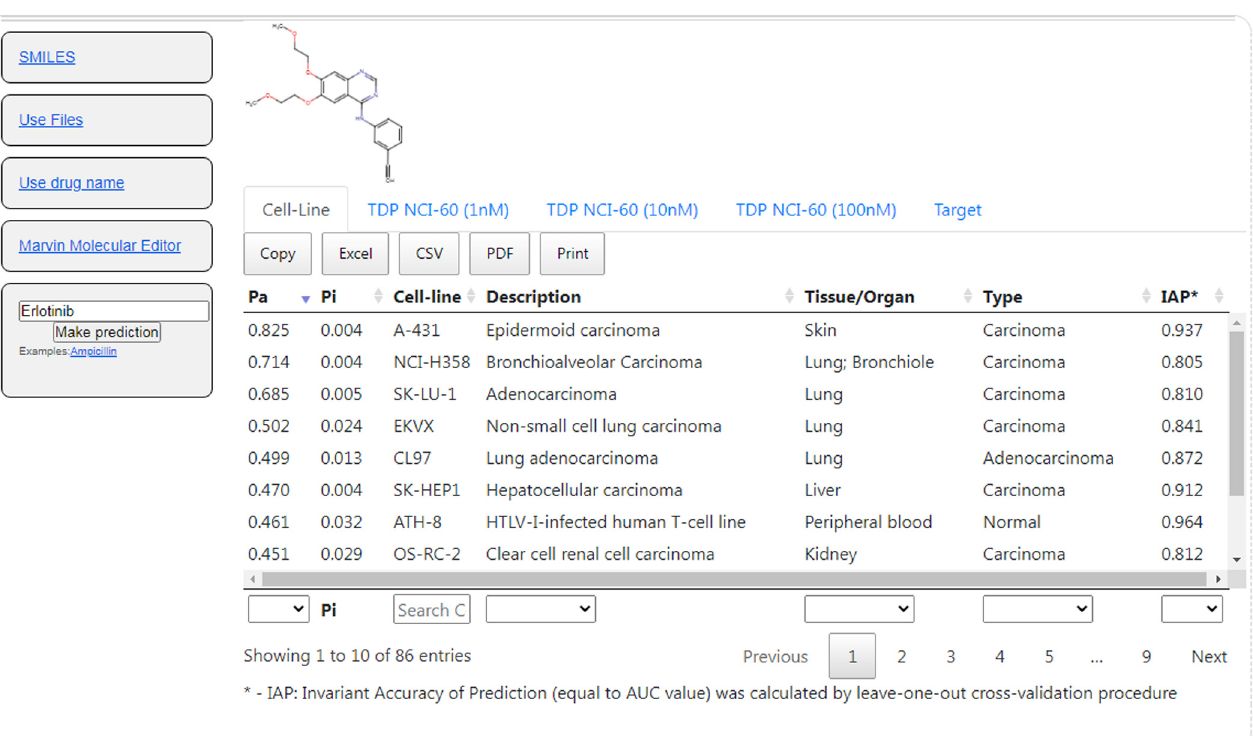
Figure 4. Interface of CLC-Pred 2.0 and prediction results of general cell-line cytotoxicity for erlo- tinib.